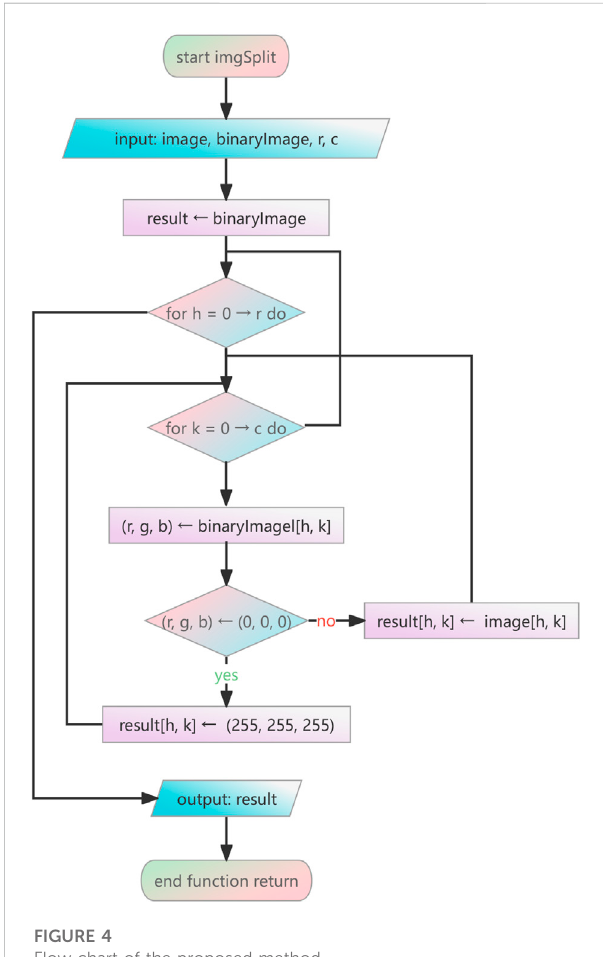
FIGURE 4 Flow chart of the proposed